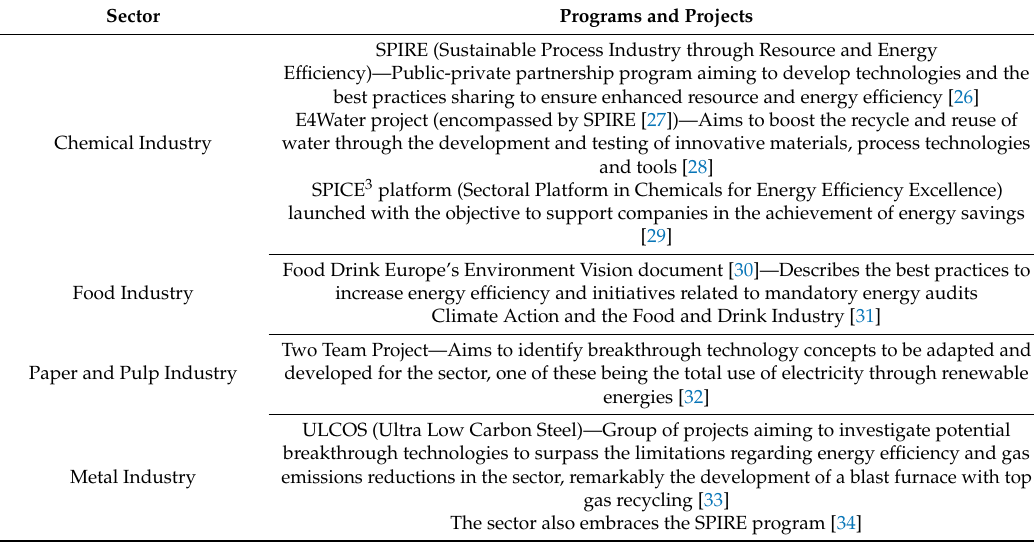
Table 2. Energy E ffi ciency Strategic and Technological Framework of each sector.